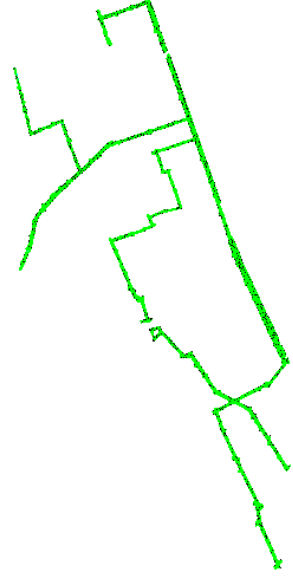
Figure 15. Overall view of the Brazil DTM final result.